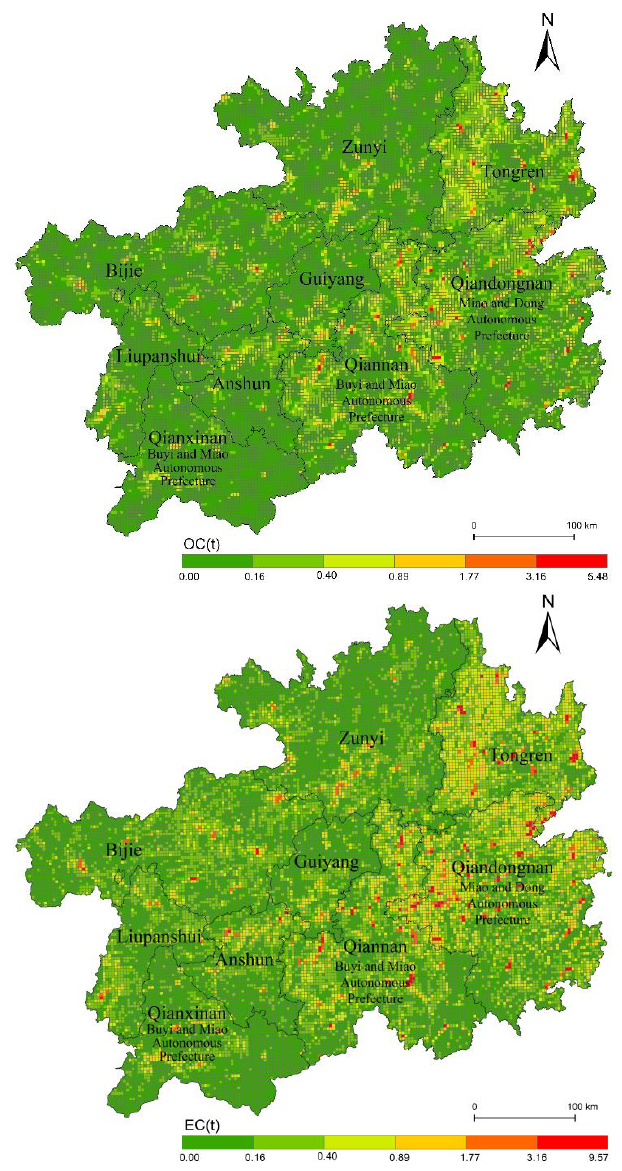
Figure 6. Spatial distribution of OC and EC emissions in Guizhou Province in 2019. In Group 1, the top three cities with the highest total carbon emissions were Qi- andongnan, Tongren, and Qiannan (Figure 6). The total emissions in 2019 were 835.9 tonnes of OC and 1561.6 tonnes EC in Qiandongnan, 646.6 tonnes of OC and 1015.1 tonnes of EC in Tongren, and 659.6 tonnes of OC and 891.9 tonnes of EC in Qiannan (Figure 7, Table 3). The total emissions from the three cities/counties accounted for approximately 60% of the total OC emissions and 62% of the total EC emissions in the province. These emissions resulted from the high proportion of households that use biomass as fuel in these regions, which is around 51% in Qiandongnan, 36% in Tongren, and 56% in Qi- annan; the corresponding consumption amounts were 47.6, 52.1, and 31.4 tonne km −2 , re- spectively. Firewood is widely used in these three cities/counties, contributing about 99% and 100% of the OC and EC emissions in Qiandongnan, respectively, and also dominating EC emissions in Tongren (98%) and Qiannan (95%). Approximately 81% of the OC was from firewood burning in Tongren followed by 11% from rice straw burning, 5% from pepper straw burning, and 3% from other sources. In Qiannan, OC emissions were also mainly from the burning of firewood, rice, and pepper straw, representing 68%, 16%, and 11% of the total emissions, respectively.